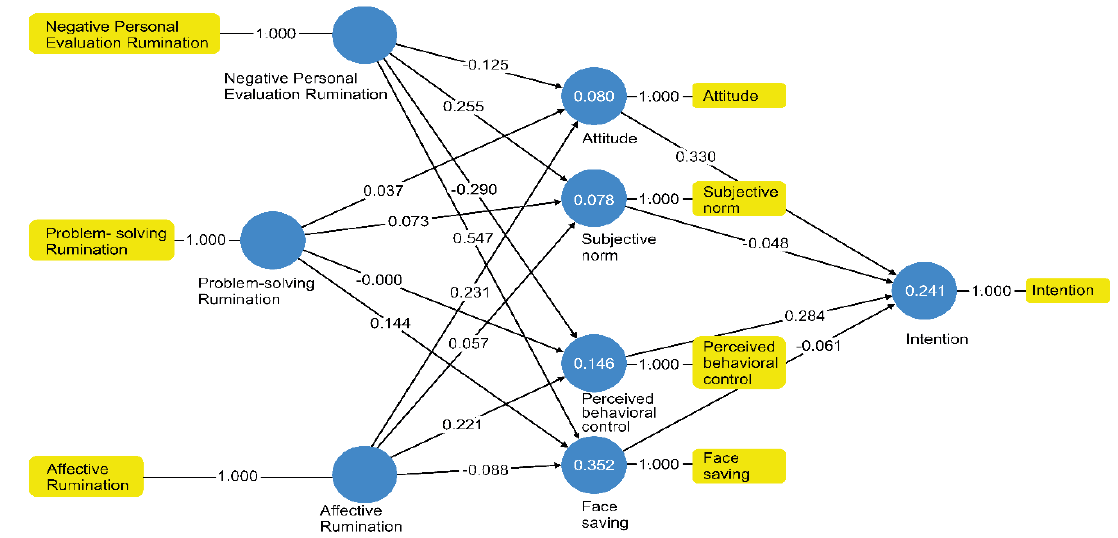
Figure 2. Partial Least Squares (PLS) Path Analysis for the Modified Theory of Planned Behavior and Leisure Rumination.